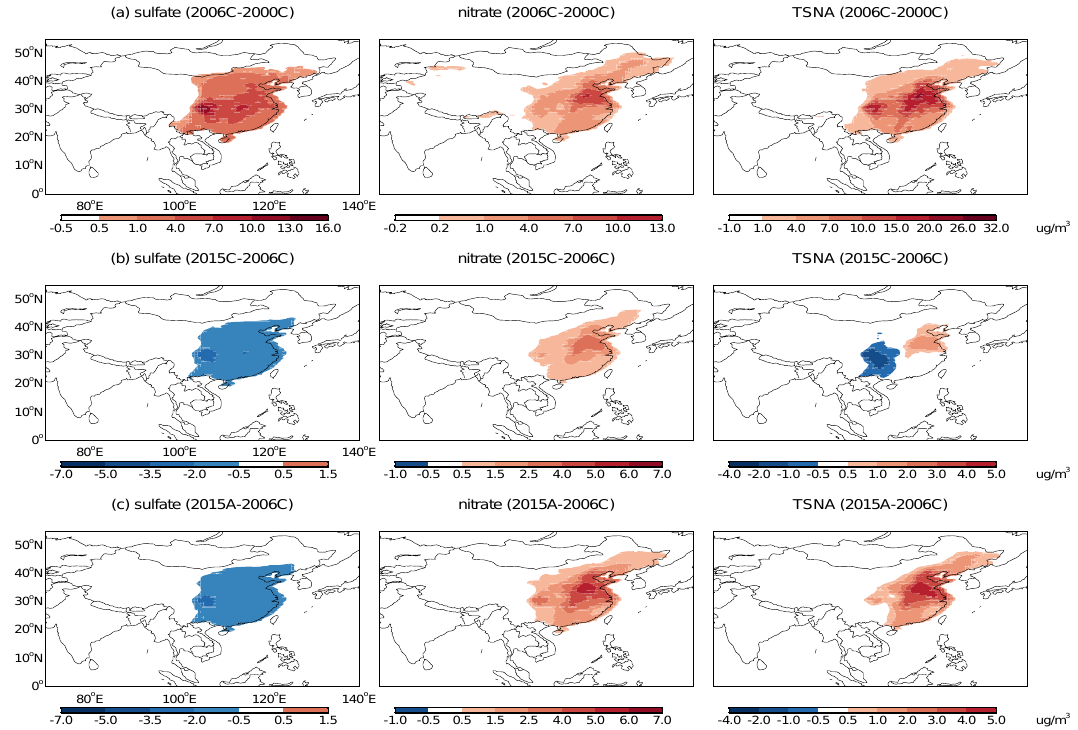
Fig. 12. The changes in mass concentrations of sulfate (left), nitrate (middle), and TSNA (right) from 2000 to 2015. (a) The changes from 2000C to 2006C; (b) the changes from 2006C to 2015C; and (c) the changes from 2006C to 2015A. Note that the color scale in (a) is different from that in (b) or (c)